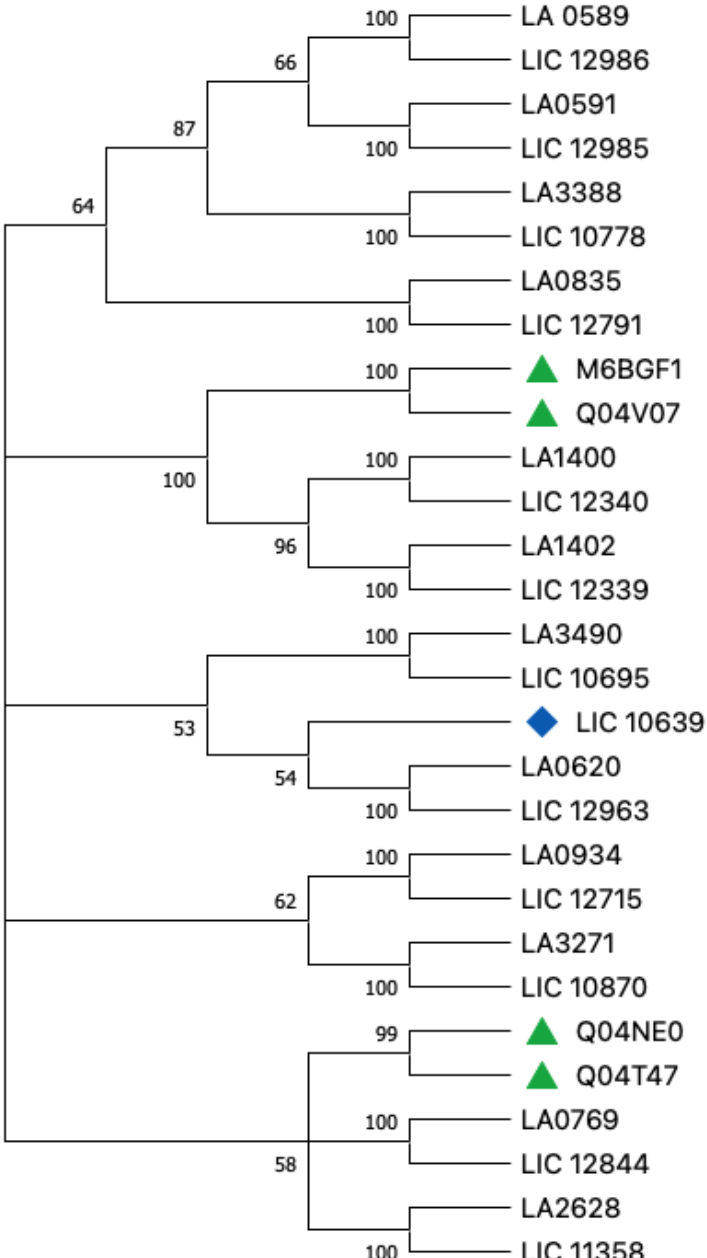
Figure 1. Preliminary phylogenetic tree using amino acid sequences from VM proteins from L. interrogans Lai (LA), L. interrogans Copenhageni (LIC), and L. borgpeterseni , based on Fouts et al. [17] and Putz et al. [37], data. Legend: LA is related with L. interrogans Lai; Green (triangle)— L. borgpeteersenii VM proteins; Blue (rhombus)—LIC is the VM protein that does not have an ortholog as a match and is related with L. interrogans Copenhageni.